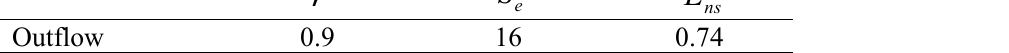
Table 3. The results of Nash-Sutcliff coefficient, correlation coefficient, and the standard error. Criterion